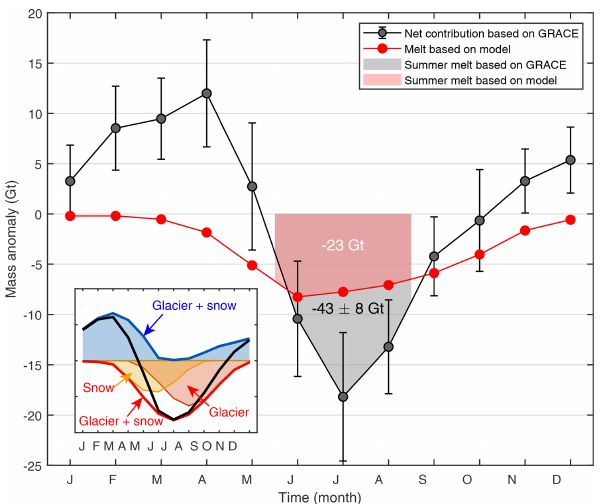
Figure 8. Monthly mass change from GS in the upper Brahmaputra basin estimated by GRACE and by the model of Lutz et al. (2014). Negative values mean a net increase in meltwater (i.e. more GS melt than accumulation). Note that Lutz’s model only estimated the melt component, while GRACE detects the net change including both melt and accumulation. The estimates of summer melt are anno- tated. A schematic diagram of seasonal mass balance is shown in the inset (blue text represents mass accumulation, red represents ablation, and the black curve represents the net change). Note 85% of the meltwater in our study region runs into the Brahmaputra, and this amount comes from 83% of the glacierized area in this basin; we scale our result by 1 × 0 . 85 / 0 . 83 to be comparable with the model